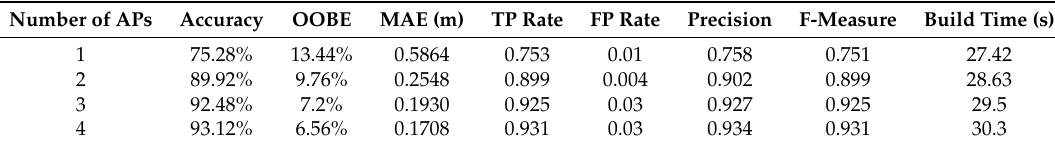
Table 3. Performance comparison between different numbers of access points